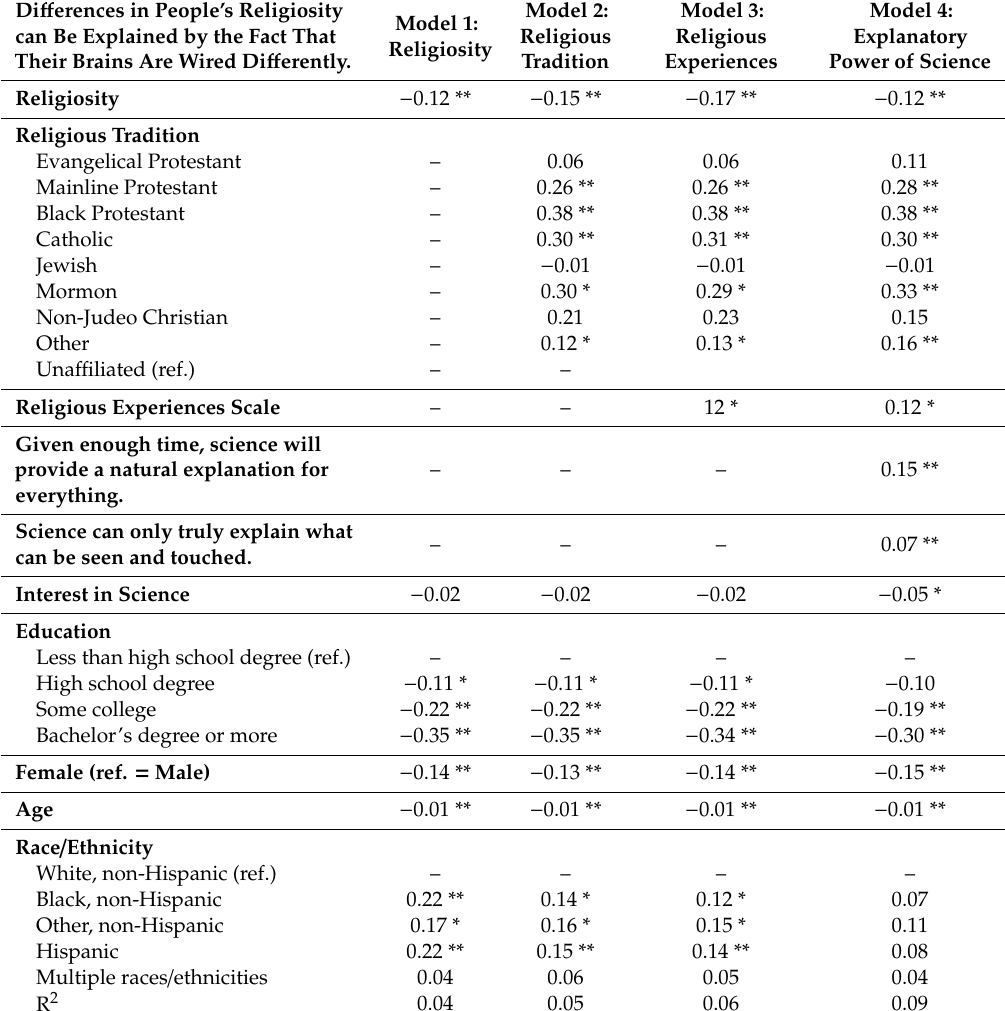
Table 4. Ordinary Least Squares Regression Models Predicting Agreement that Brian Wiring Explains